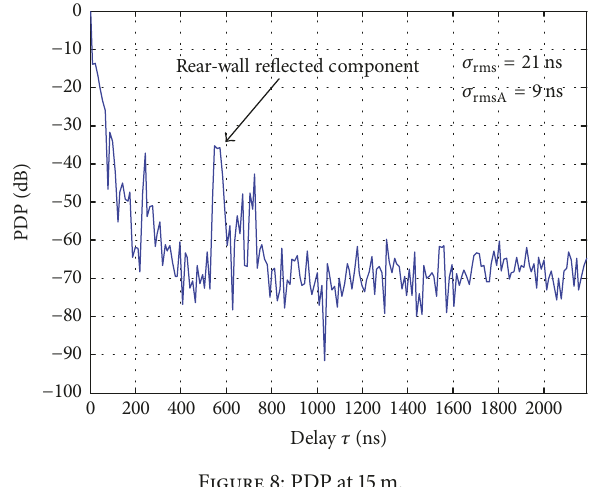
Figure 8: PDP at